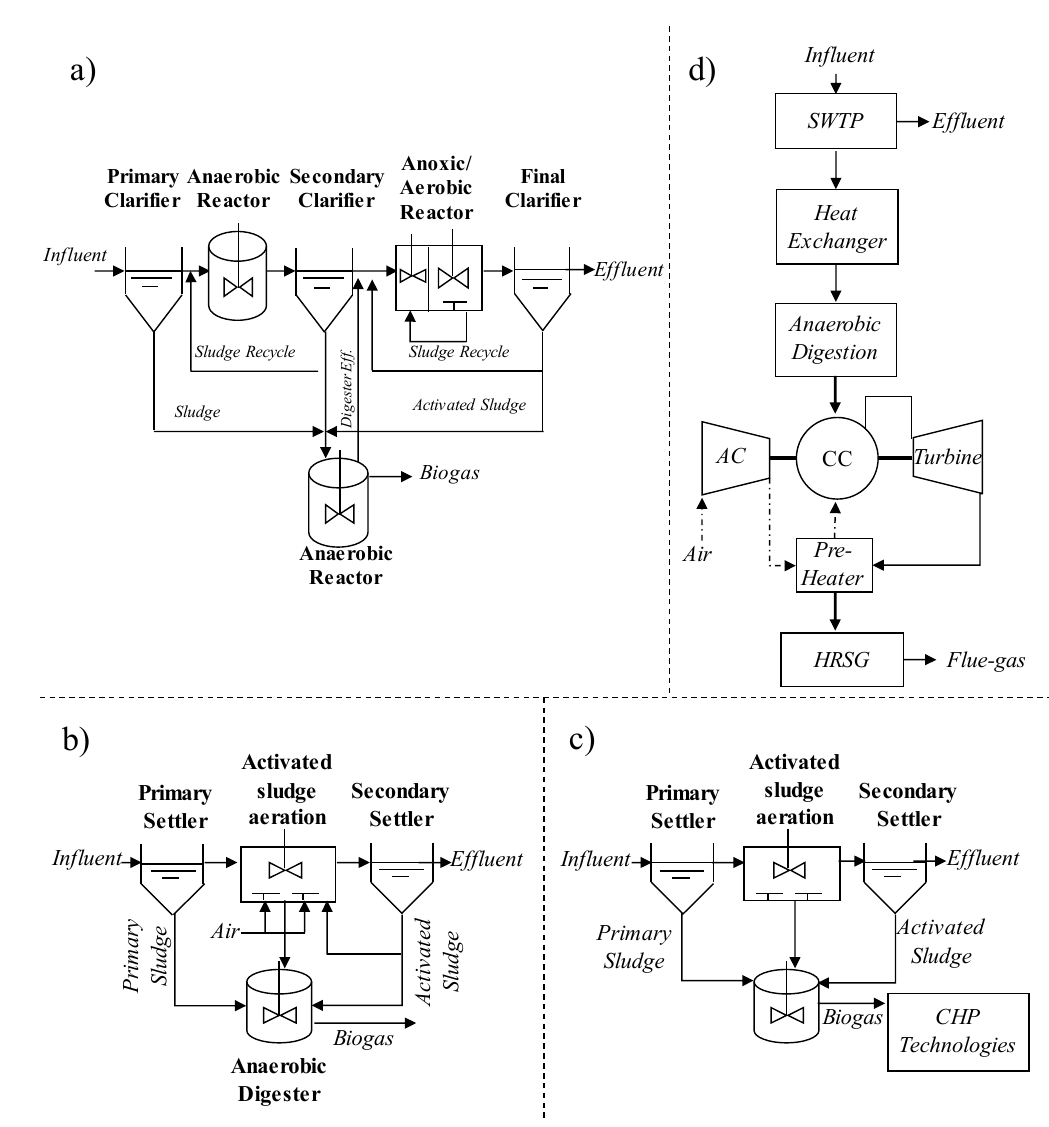
Figure 1. ( a ) SWTP with sewage-sludge AD [17]; ( b ) primary and secondary treatments with sludge